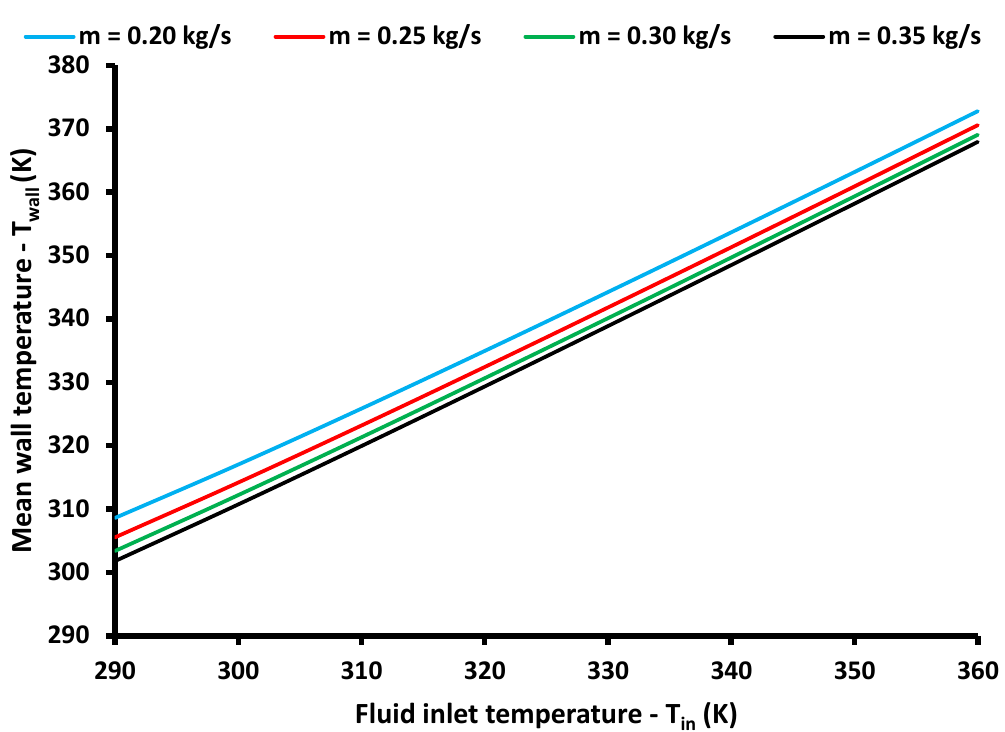
Figure 13. Mean wall temperature variation for the different operating scenarios in the reference case of the empty tube.